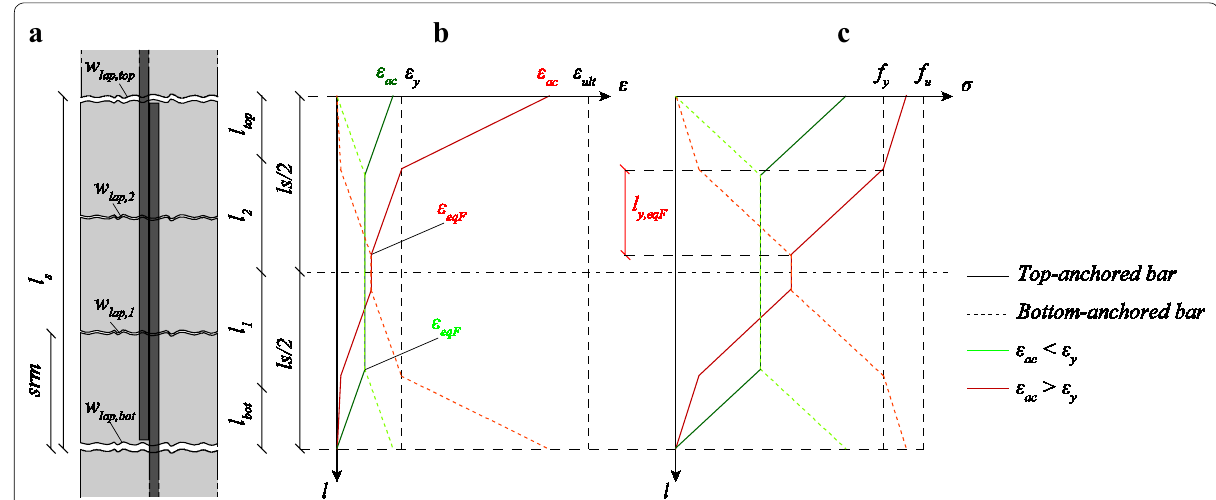
Fig. 6 Lap-splice element: a Sketch. b Qualitative steel strain profile. c Qualitative steel stress